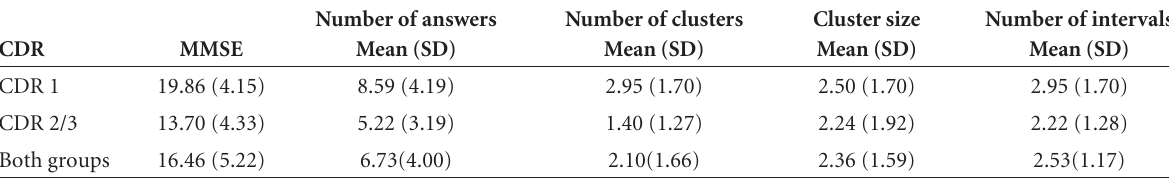
Table 2. MMSE and CDR scores, number of generated answers, clusters, cluster size and intervals on